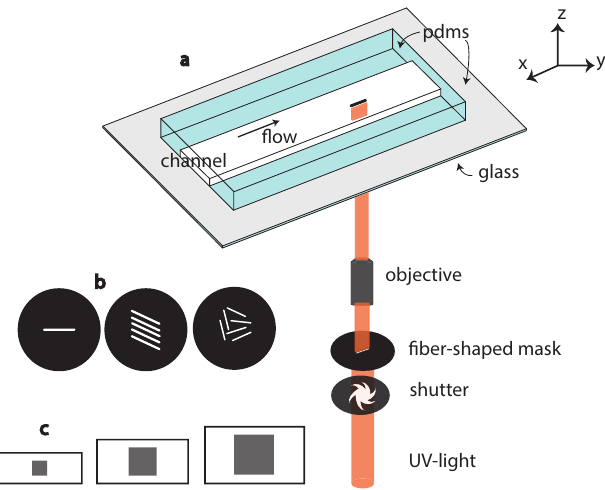
Figure 1. ( a ) Schematic drawing of the in situ fiber fabrication technique, using a microscope-based projection lithography technique. UV light is projected into the channel through a fiber-shaped mask, polymerizing the polymer inside the channel, typically within 100 ms; ( b ) one or several fiber shapes can be used on the mask depending on the number of fibers to make in one step; ( c ) the polymerization is prevented close to the PDMS walls due to the presence of oxygen allowing free fibers to be fabricated. The thickness of the inhibition layer being constant, the confinement increases with the channel